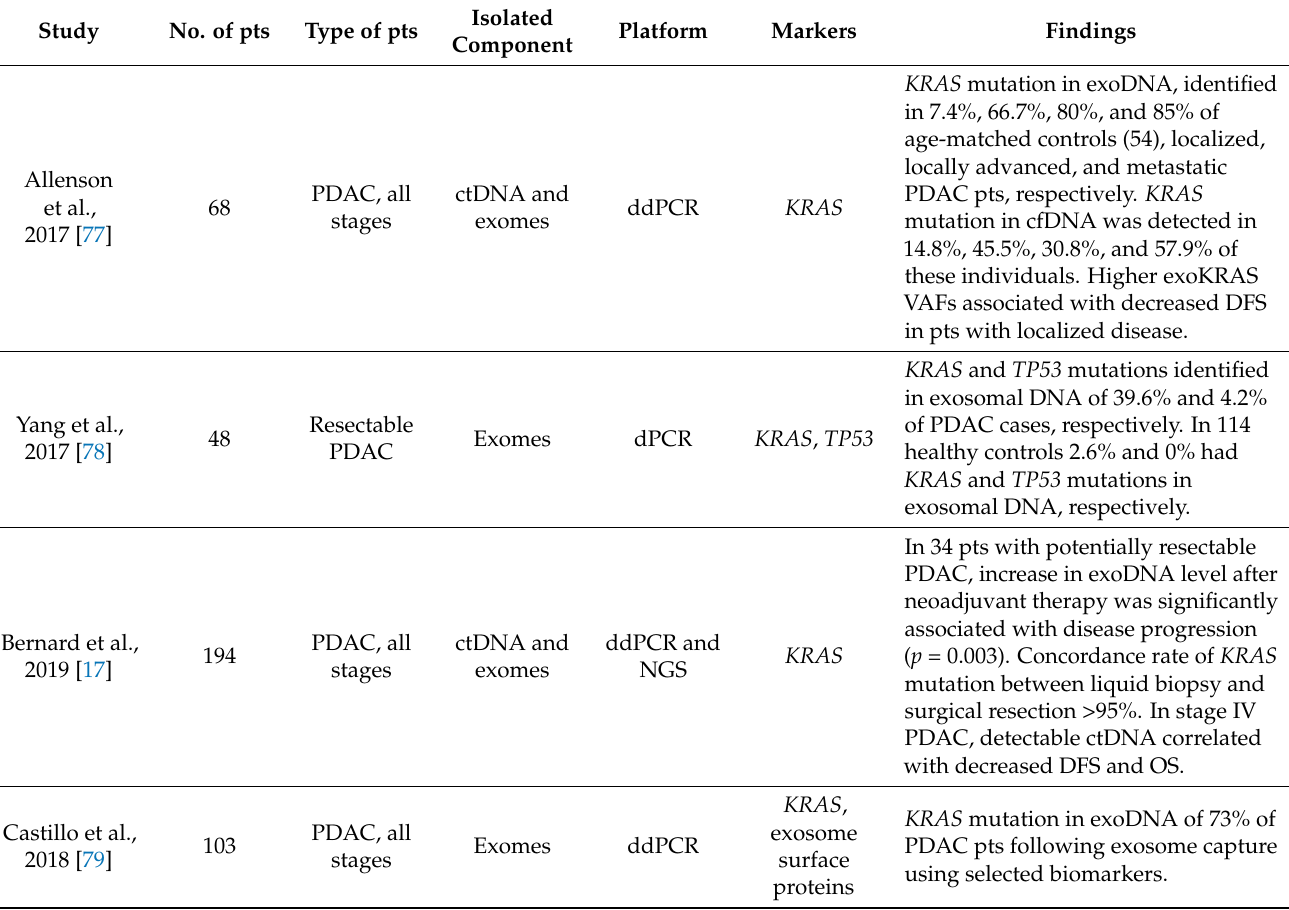
Table 2. Studies of exosomal liquid biopsy in pancreatic ductal